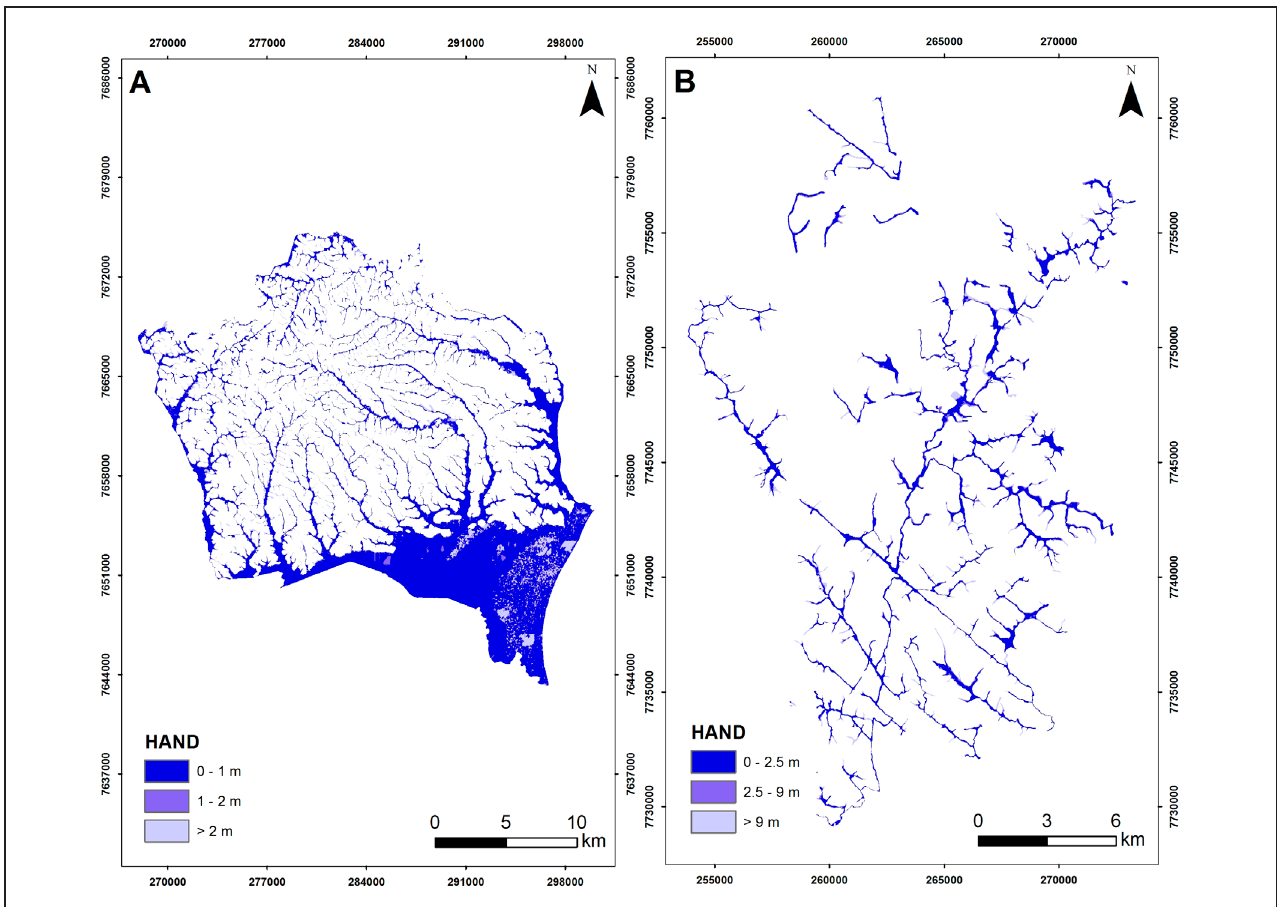
Figure 6 - Raster classification of terrain susceptibility to flooding, based on the HAND model.